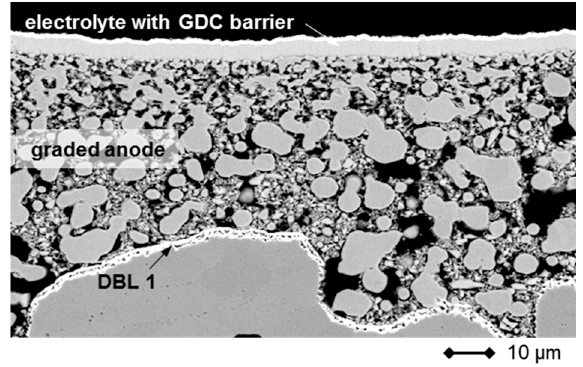
Figure 12. SEM-image of a cross section through the graded anode of an MSC before application of the cathode.